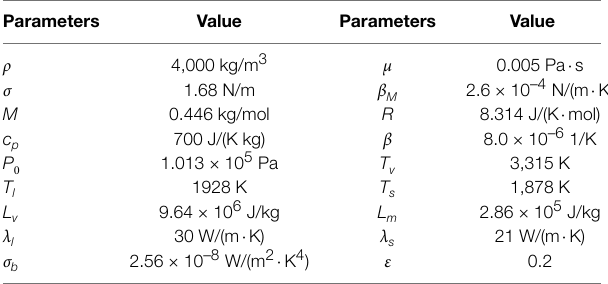
Parameters Value